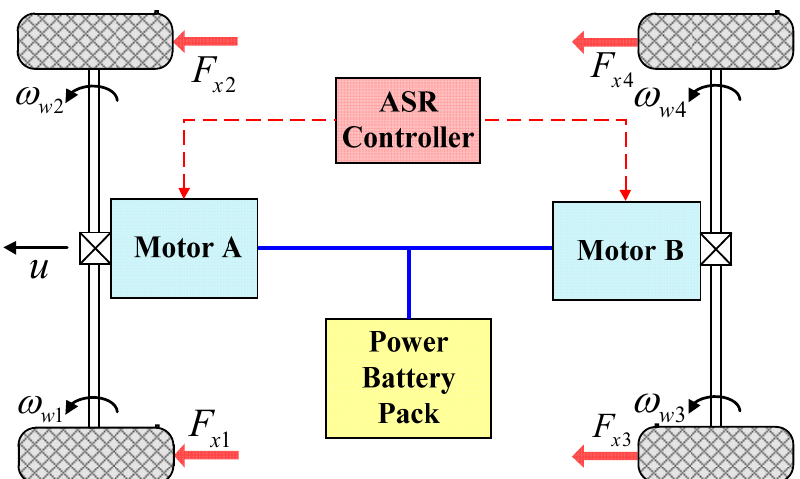
Figure 1. The four-wheel drive (4WD) electric vehicle acceleration slip regulation (ASR) system